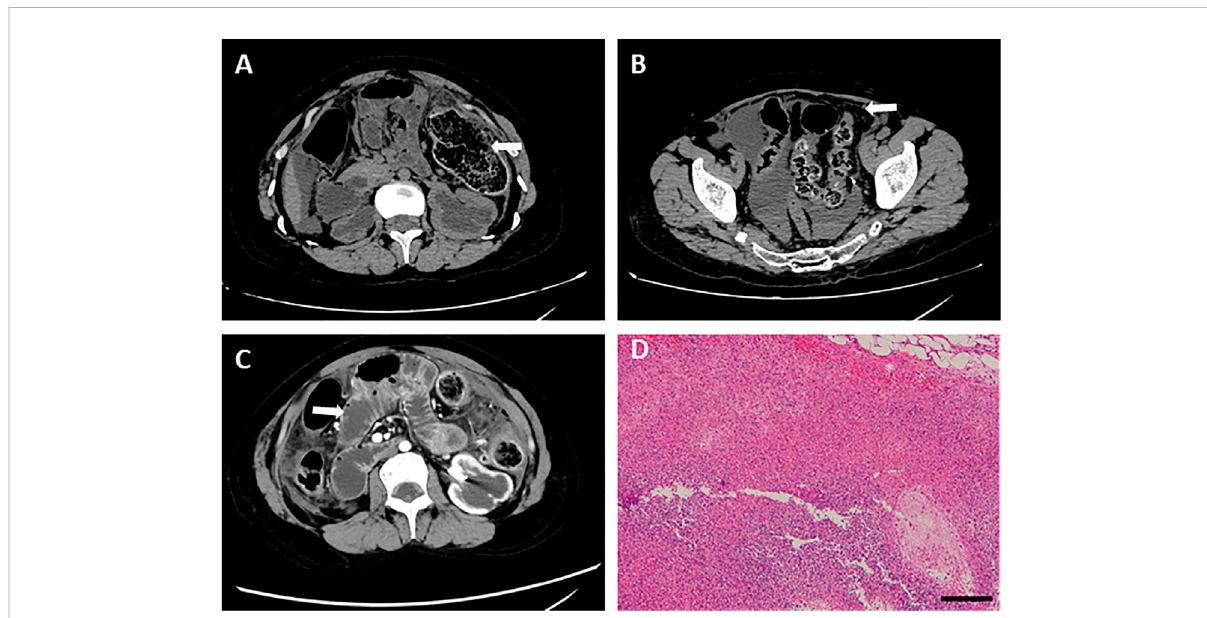
FIGURE 3 Abdominal CT images before the operation for intestinal perforation and pathological detection. (A) Intestinal wall of the splenic fl exure of the colonwasdiscontinuous. (B) Abdominalandpelviceffusion. (C) Dilatedduodenumandjejunum. (D) HEstainingwasperformedusingsplenic fl exure of the colon, showing a large number of in fl ammatory cell in fi ltration and abscess formation. Bar = 200 μ